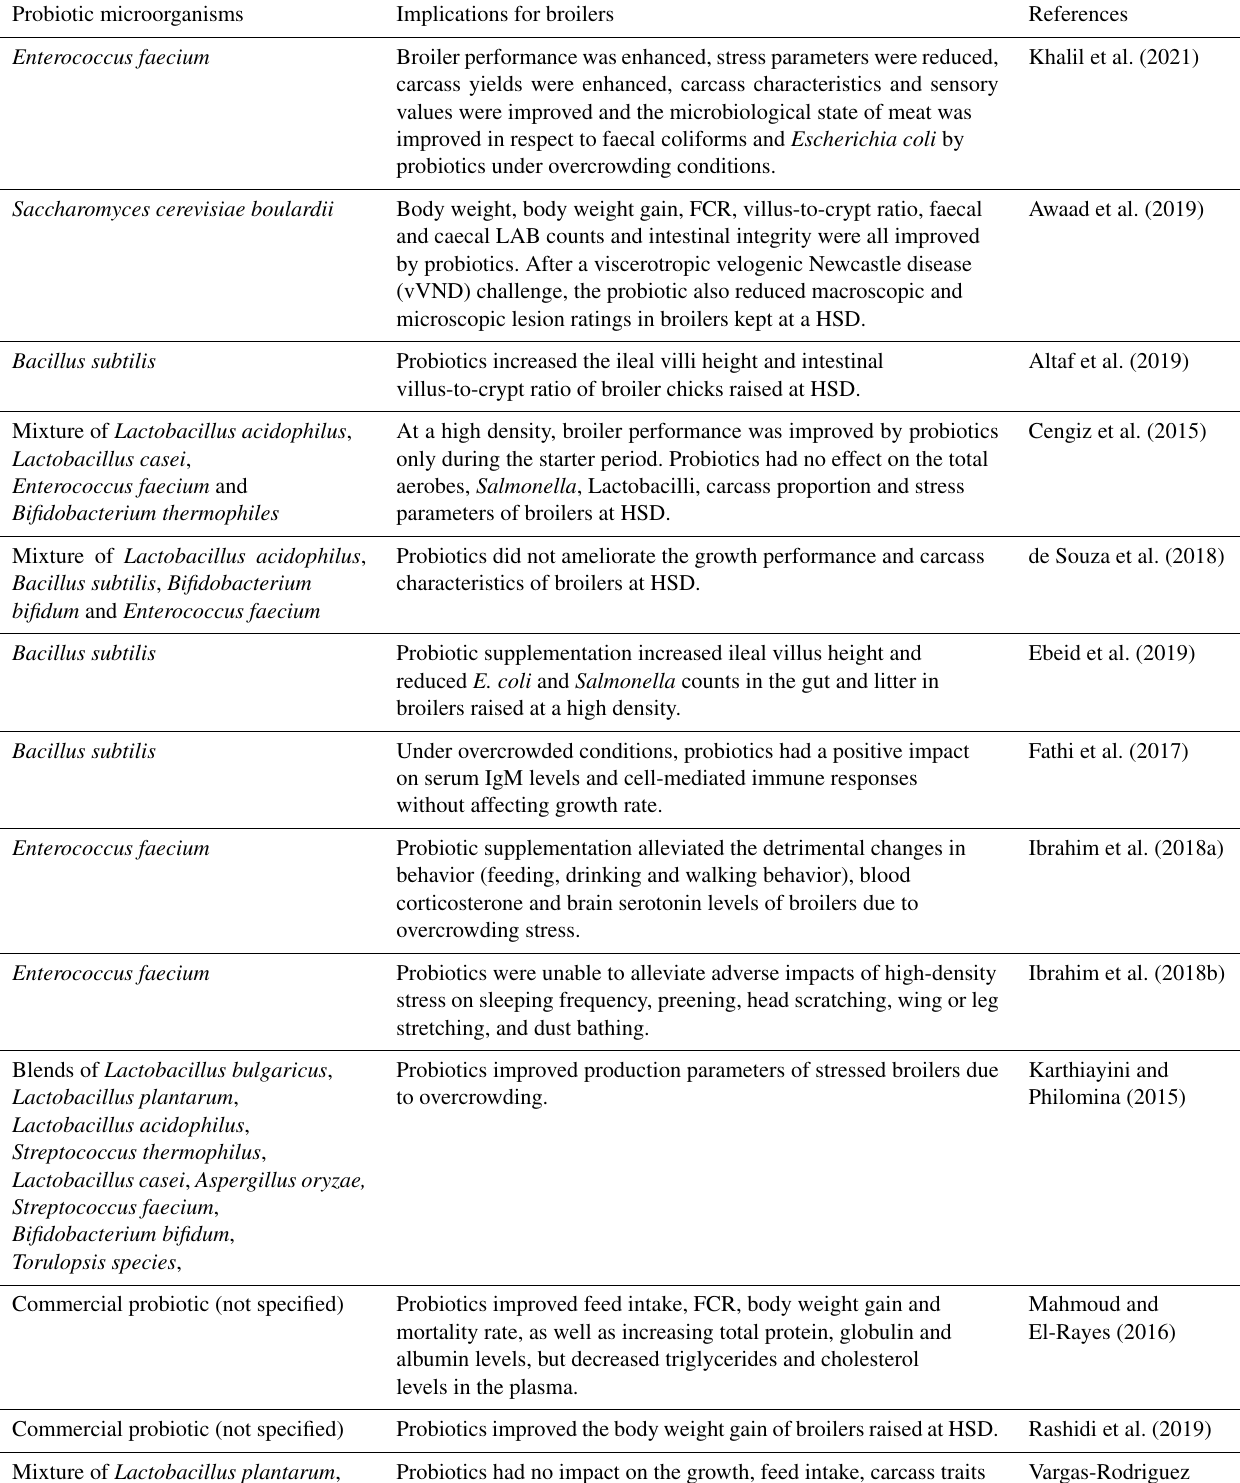
Table 1. The use of probiotics in broilers raised at a high stocking density. Probiotic